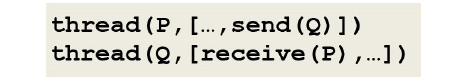
FIGURE 3 | Thread patterns for a synaptic transmission. Thread P will fire in reaction to the capture of an external stimulus, with the send procedure corresponding to sending a signal, or spike train, carried by a pre-synaptic neuron’s axon. In the thread Q , the receive procedure represents the reception of this signal by a post-synaptic